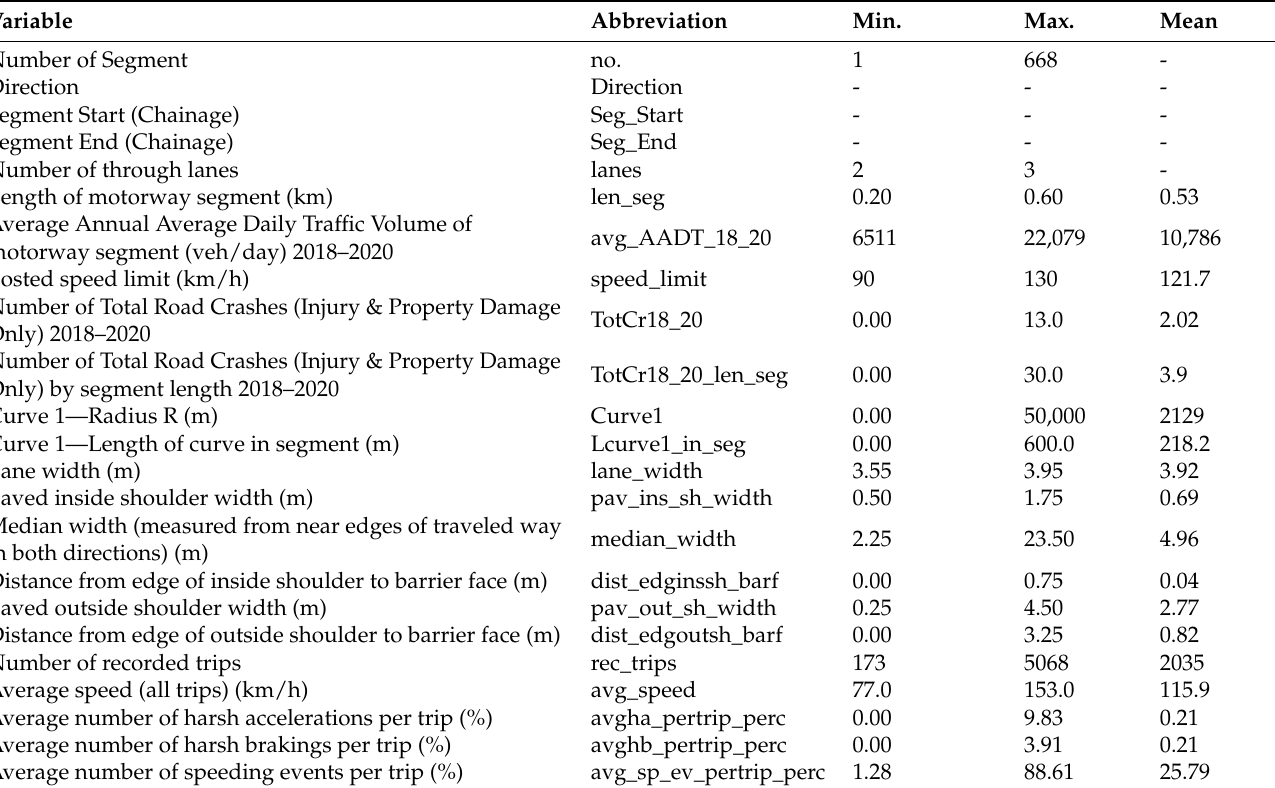
Table 1. Road crash, traffic, geometry, and driver behavior variables per